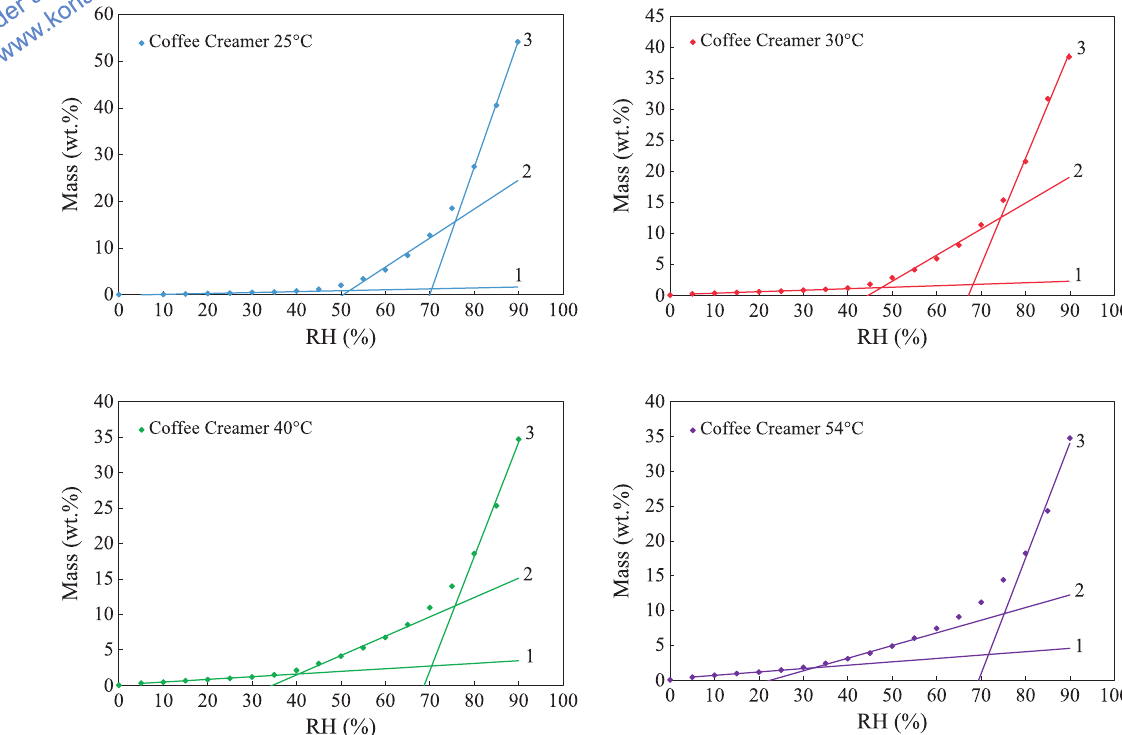
Fig. 4 Adsorption isotherms of the coffee creamer sample at 4 different temperatures, 25 °C, 30 °C, 40 °C and 54 °C, with the three fitted regions in the isotherms obtained with the Dynamic Vapor Sorption tech -